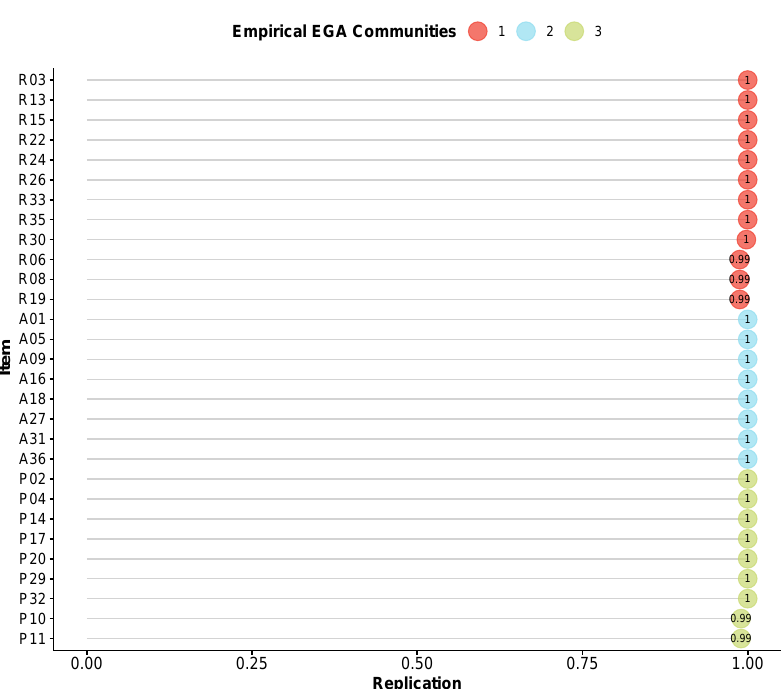
Figure 7. Item stability of the Broad Autism Phenotype Questionnaire after removing the unsta- ble